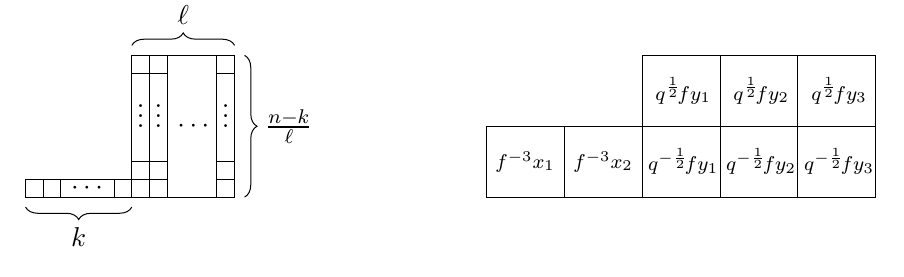
Figure 6 . The left picture shows the Young diagram Y ( ‘ ) with n boxes. Here k and ‘ are non- k negative integers such that n (cid:0) k is a positive integer. There are k columns of height one and ‘ ‘ columns of height n (cid:0) k . We also use the shorthand notation Y simple (cid:17) Y (1) and Y full (cid:17) Y ( n ) = Y (1) 1 0 n (cid:0) 1 ‘ in the main text. The right picture shows how the SU( n ) fugacity w in (3.6) is related to the SU( k ) (cid:2) SU( ‘ ) (cid:2) U(1) fugacities ( x ; y ; f ) (in the particular case of n = 8 ; k = 2, and ‘ = 3), where w 1 ; (cid:1) (cid:1) (cid:1) ; w n are assigned to the